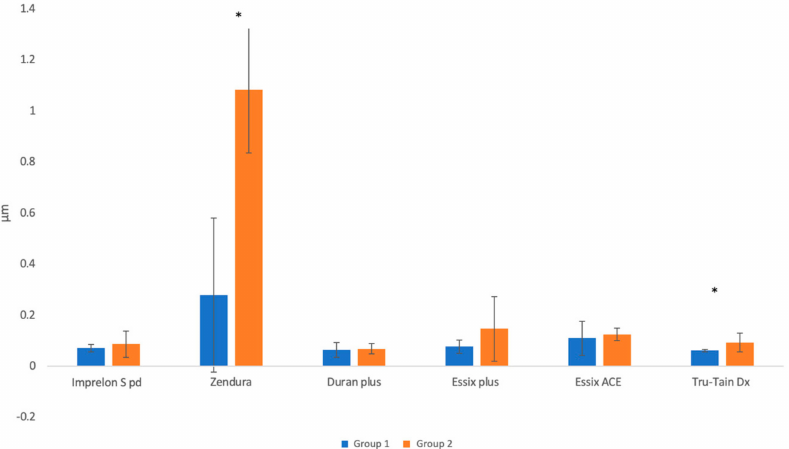
Figure 9. Mean ± SD of surface roughness values of Group 1 and Group 2 (the * symbol indicates a significant difference between the two groups for the same material at p < 0.05